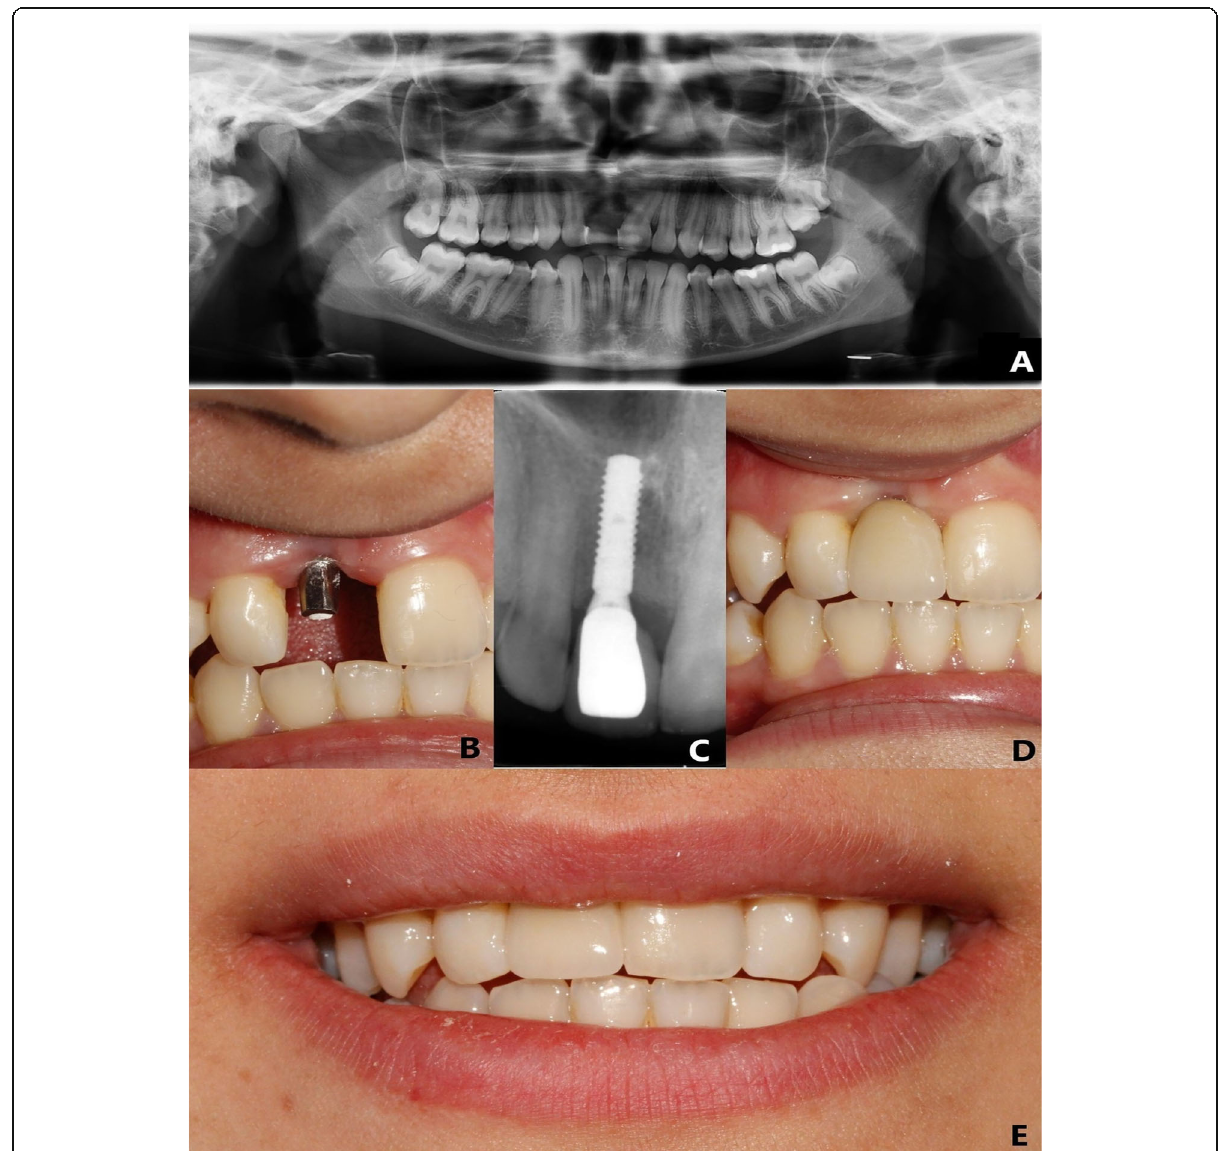
Fig. 1 a Pre-operative panoramic radiograph of the patient, ( b ) abutment in place, following the osseointegration period, ( c ) periapical